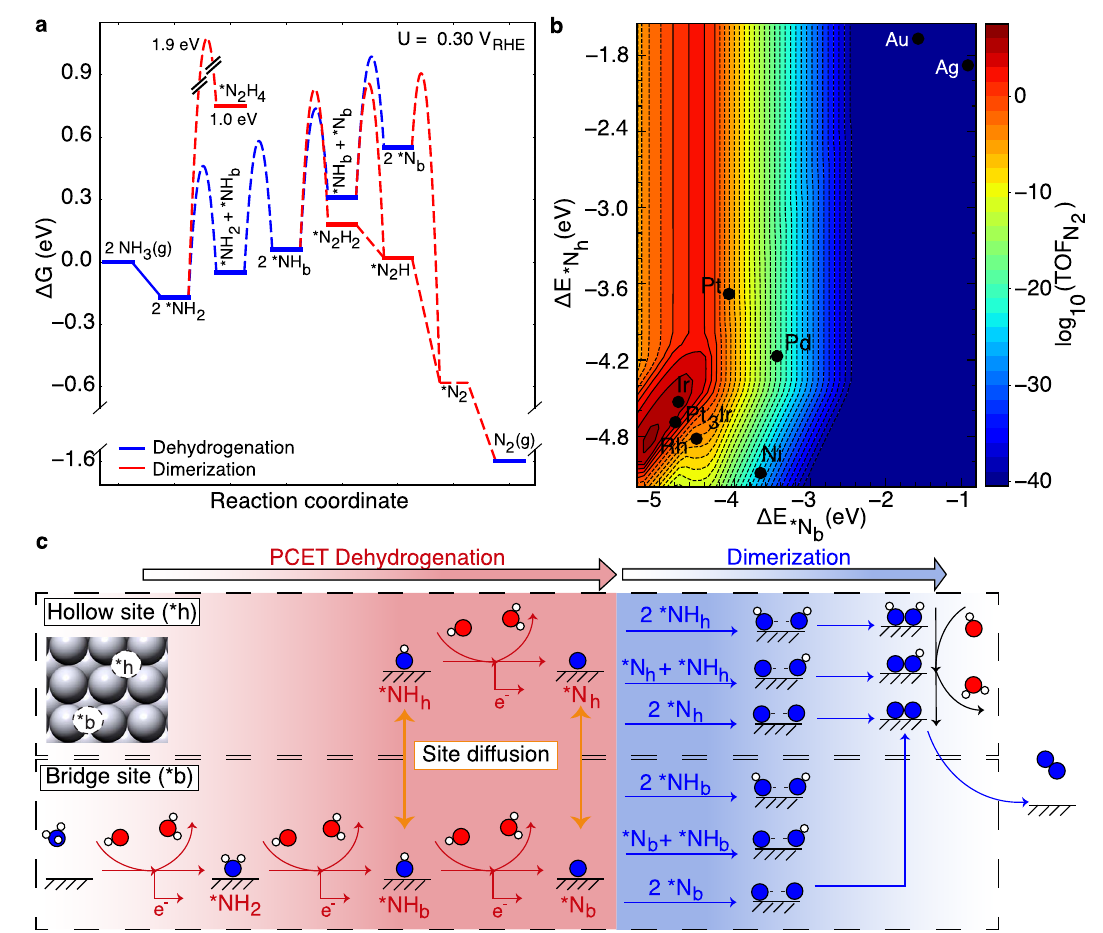
Fig. 1 | Reaction pathways of NH 3 electrooxidation and the activity volcano plot. a Free energy pro fi les of electrochemical NH 3 oxidation to N 2 on Pt(100) at 0.3Vvs.RHEfrom grand-canonicalDFTcalculations. b The activityvolcanoplotof the NH 3 electrooxidation as a function of the bridge and hollow N adsorption energies on {100}-type site motifs (reaction conditions: 0.3V vs. RHE, T =298K,